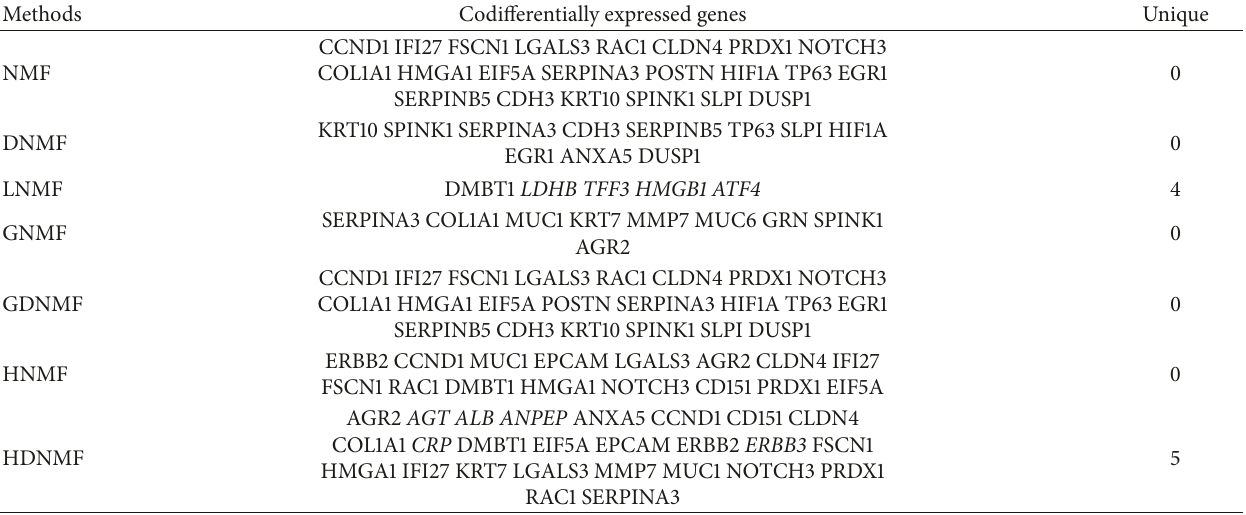
Table 9: Co-differentially expressed genes of five methods (INTA